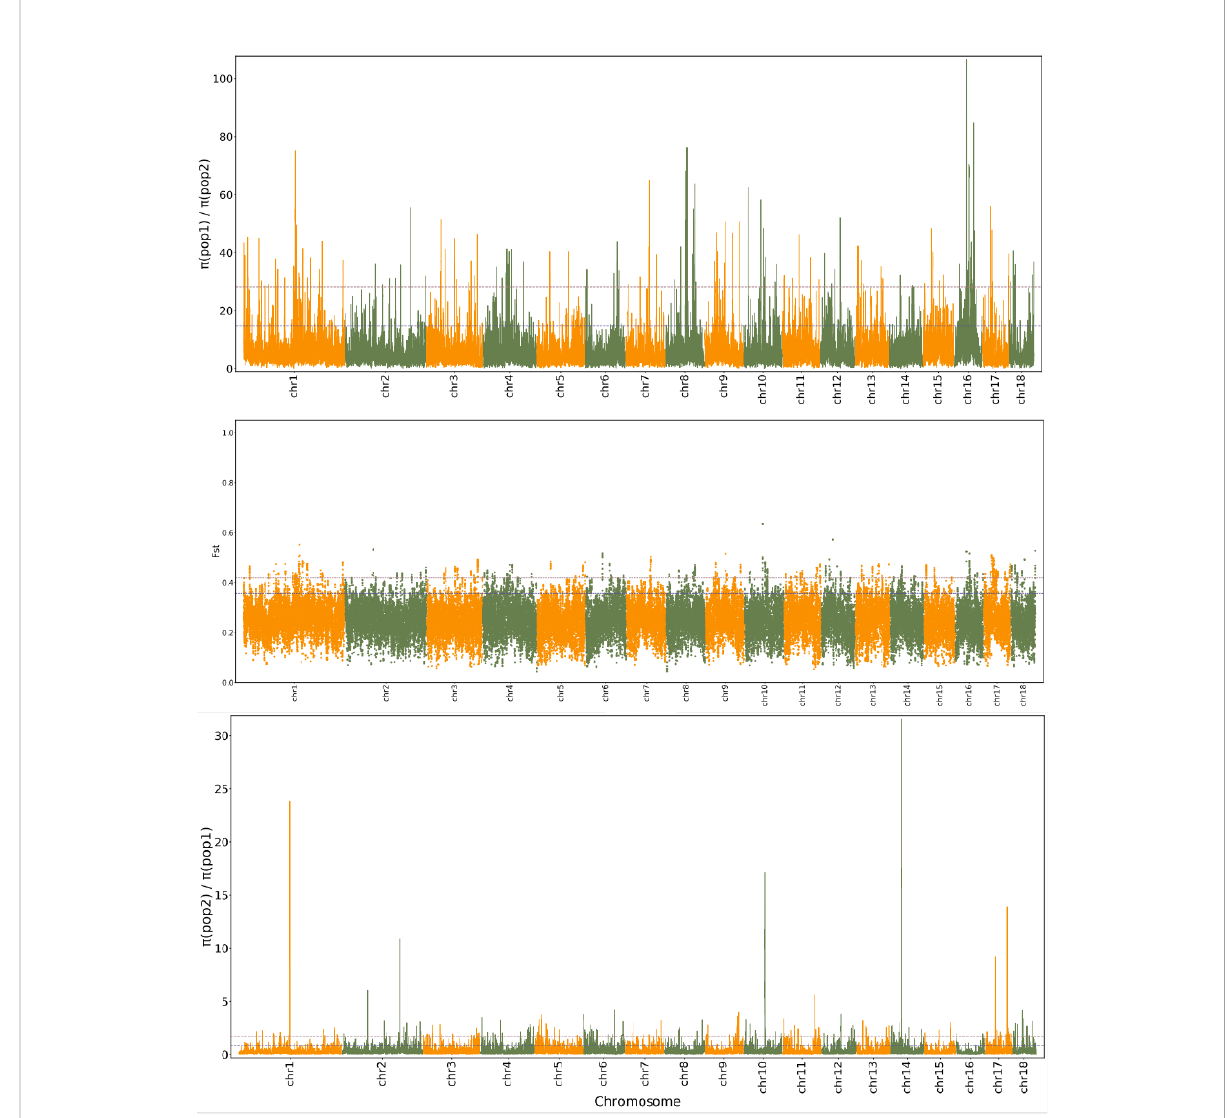
FIGURE 4 Distribution pattern of F ST and p ratio along the chromosome between GEE _pedigree and GEG _pedigree. pop1 indicates GEG_pedigree (G. elata Bl. f. glauca [GEG] individuals and G. elata Bl. f. viridis [GEV] individuals collected from GEG populations) and pop2 indicates GEE_pedigree (G. elata. Blume forma elata [GEE] individuals and GEV individuals collected from GEE